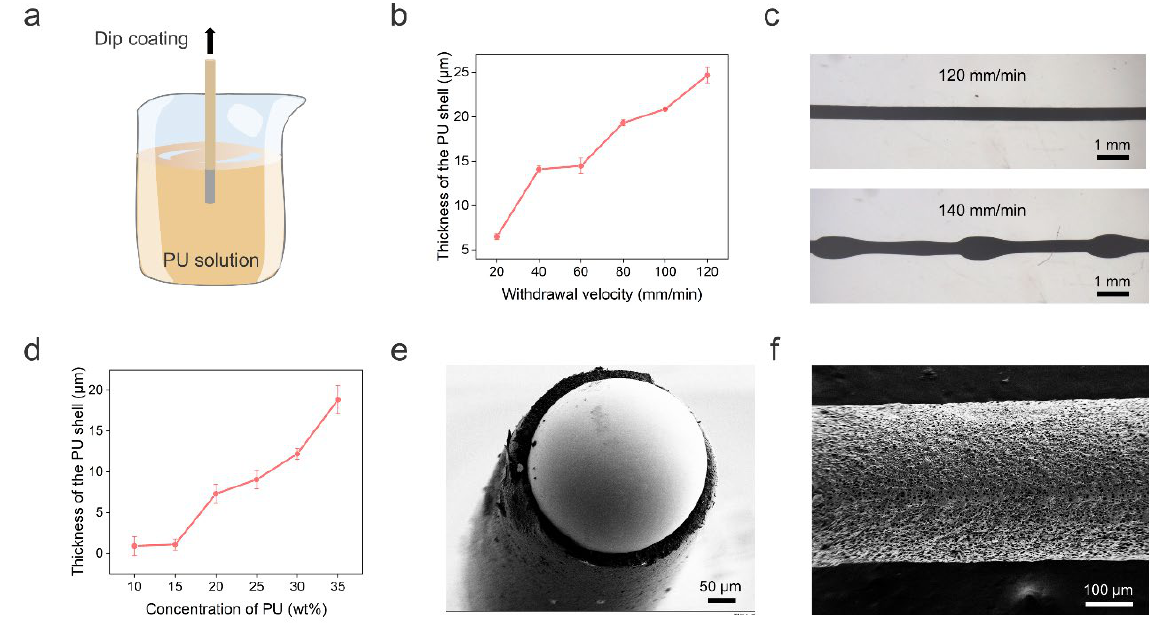
Figure 2. Preparation and characterization of the core–shell LM fiber. ( a ) Schematic illustration of the preparation of core–shell LM fiber by dip-coating. ( b ) Thickness of the PU shell as a function of the withdrawal velocity. ( c ) Representative microscope photographs of the LM fiber with 120 mm/min and 140 mm/min withdrawal velocities. ( d ) Thickness of the PU shell as a function of the PU concentration. ( e ) Scanning electron micrograph (SEM) of the cross section of the core–shell LM fiber. ( f ) SEM of the rough shell surface.